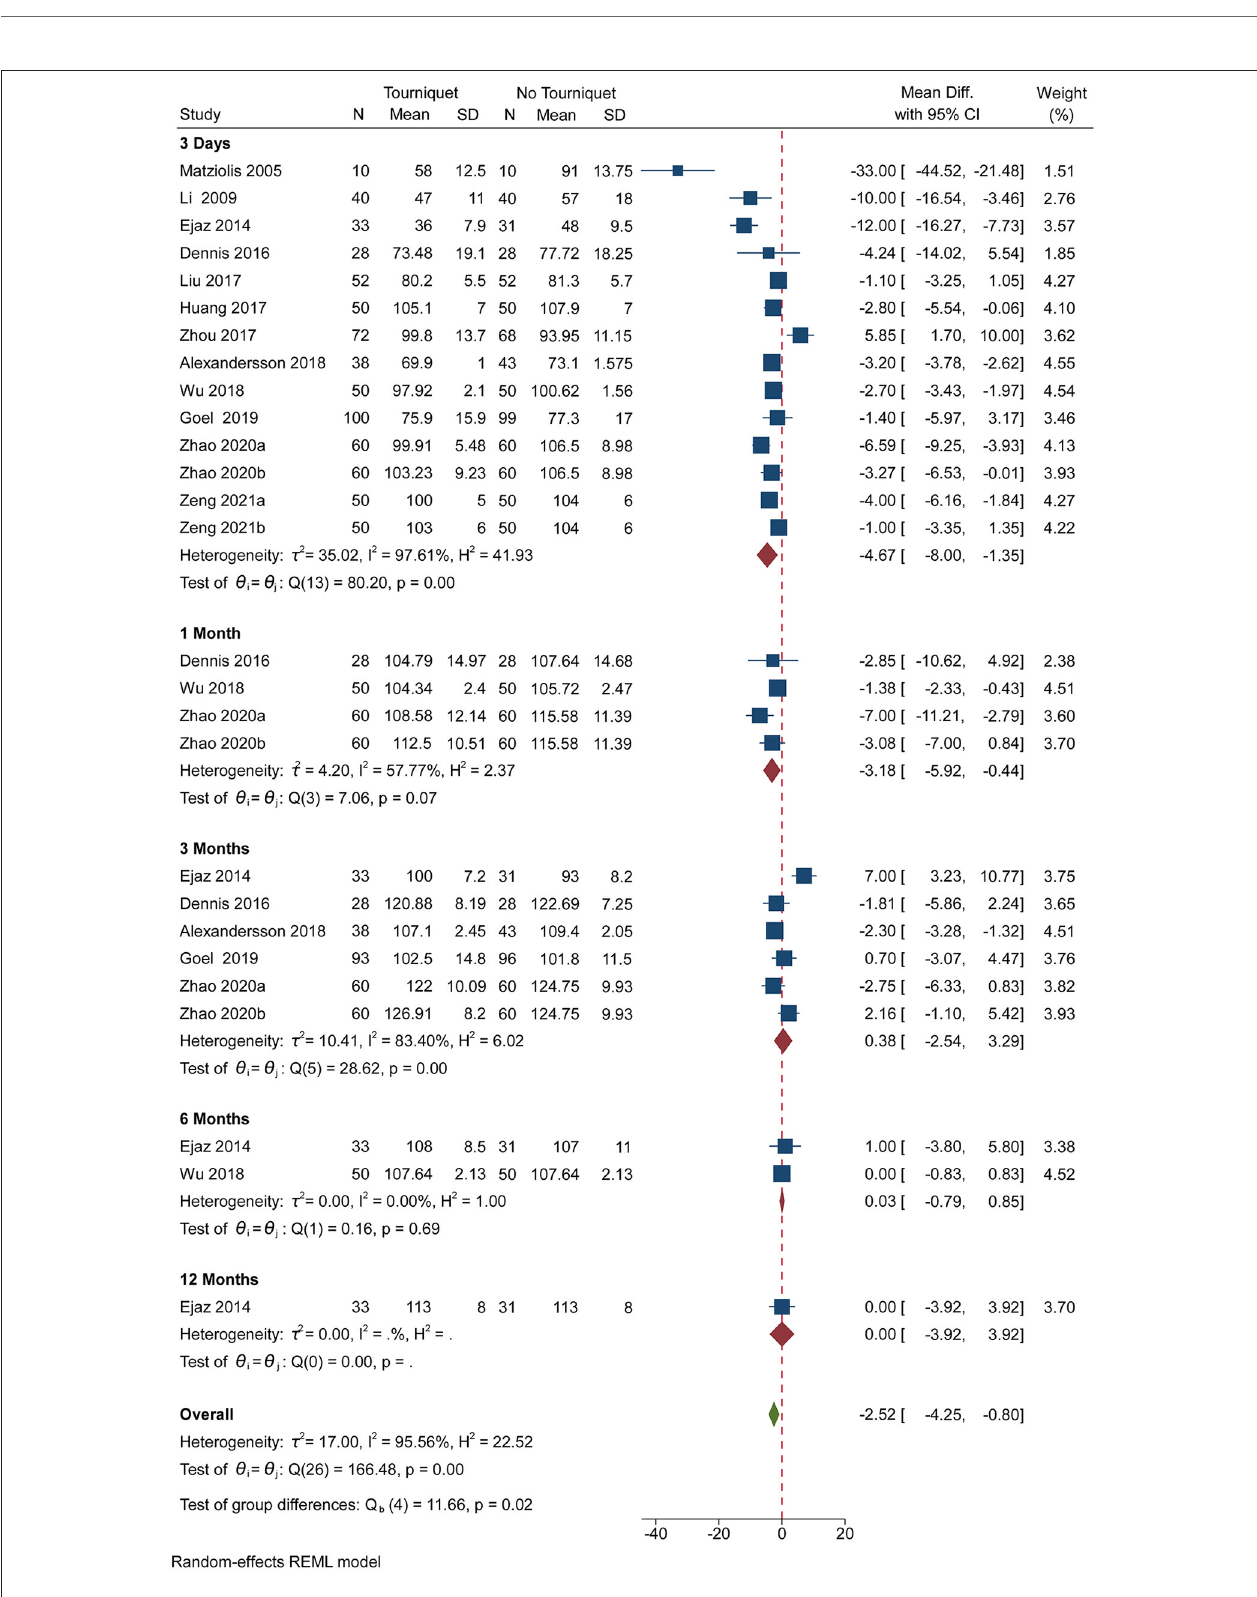
FIGURE 1 | Forest plot comparing ROM outcomes in no tourniquet and tourniquet groups.